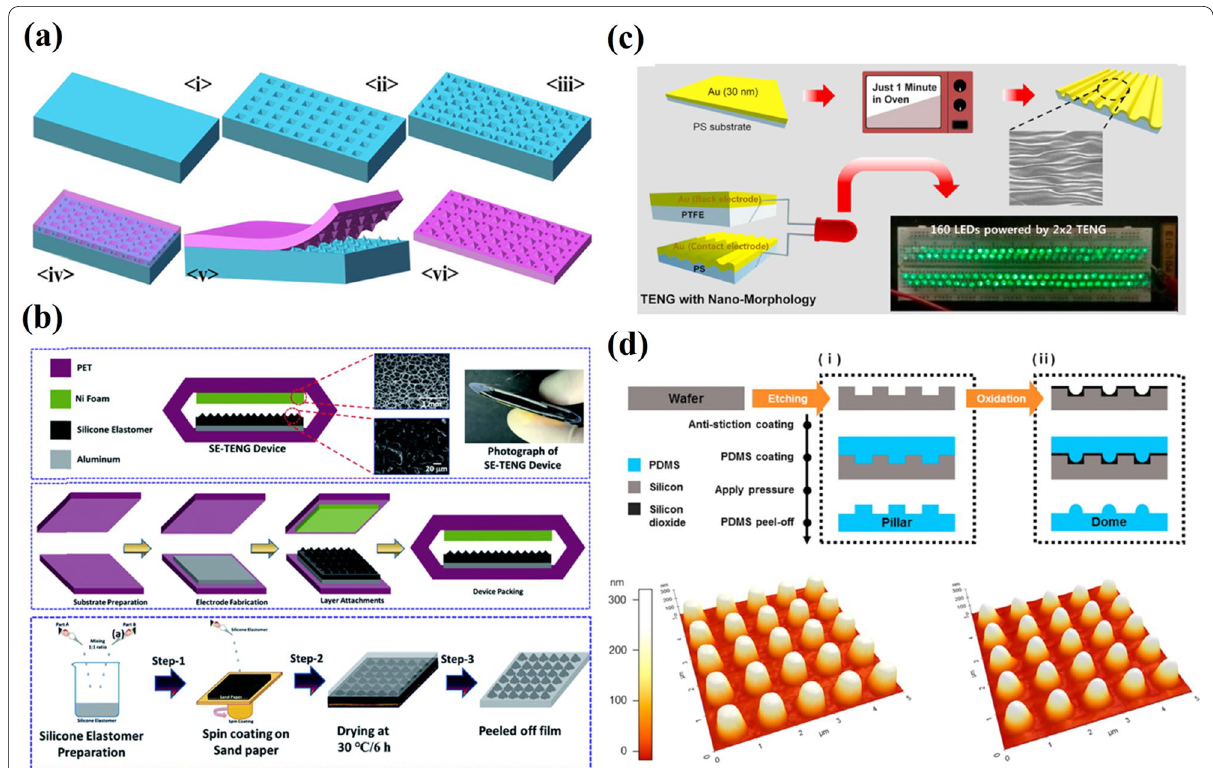
Fig. 8 Surface micro-/nano-patterning techniques: a a process flow of soft lithography (Reproduced with permission from Ref. [67]); b SE-TENG device schematic and fabrication (Reproduced with permission from Ref. [68]); c a process of the glass transition of the PS for obtaining nano-to-micro scale morphology (Reproduced with permission from Ref. [69]); d an illustration of the fabrication of the dome-shaped and pillar-shaped nanostructures by the replica molding process on the silicon wafers, and their surface taken by an atomic force microscope (Reproduced with permission from Ref.